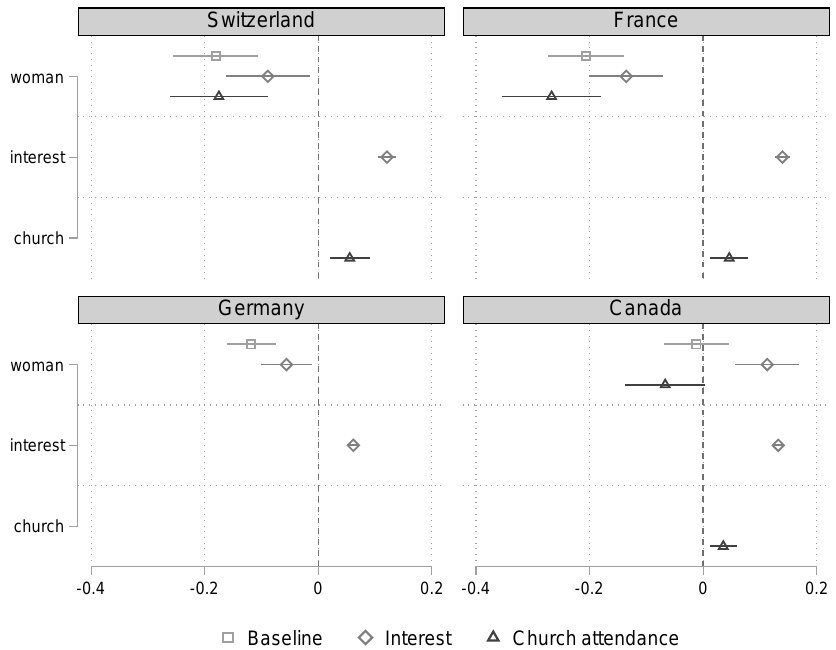
Figure 2. Alternative models to explain the gender gap regarding the duty to vote